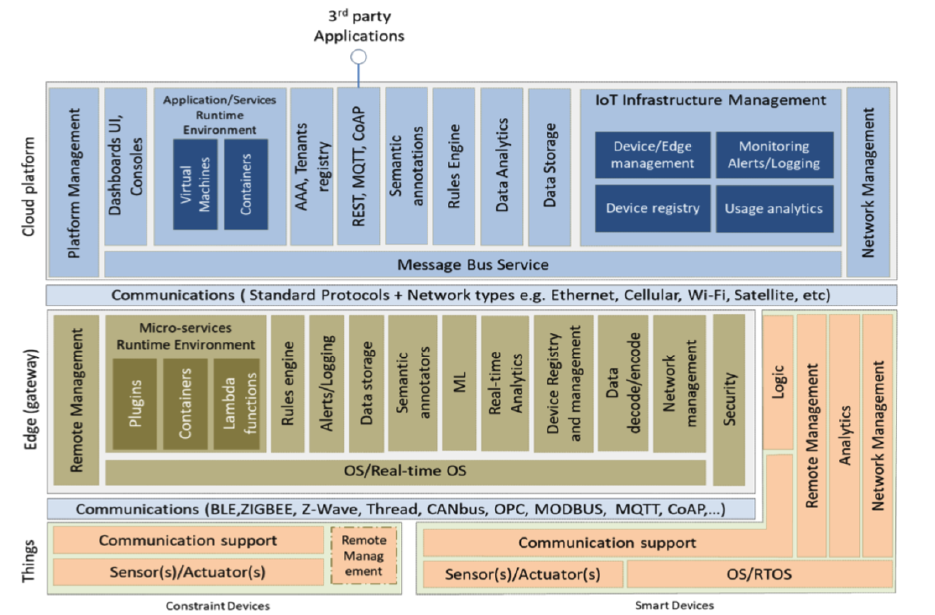
Figure 8. The three-tier Reference